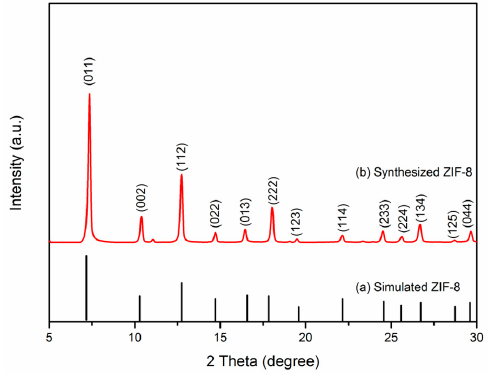
Figure 1. XRD patterns of ( a ) simulated MOF (ZIF-8) and ( b ) synthesized pure MOF (ZIF-8).